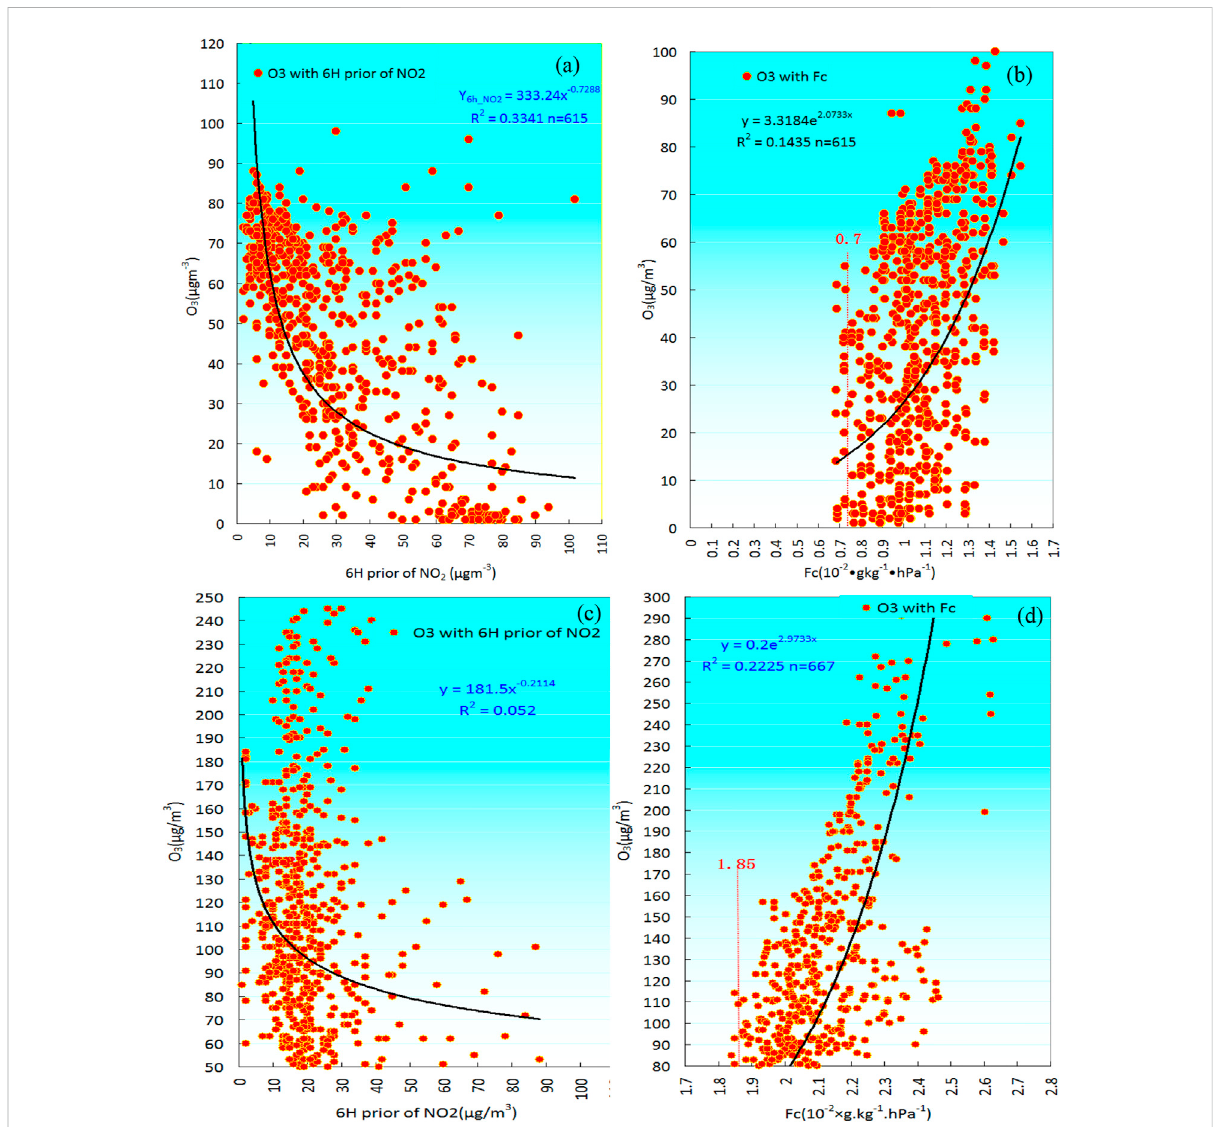
FIGURE 6 (A) Correlation analysis of the hourly resolution O 3 and NO 2 before 6H in Beijing in February 2022, (B) correlation analysis between the hourly resolution